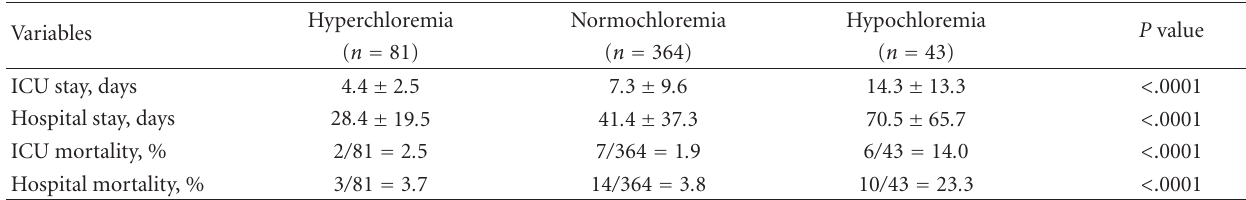
Table 3: Length of stay and mortality in hyperchloremic, normochloremic, and hypochloremic patients.